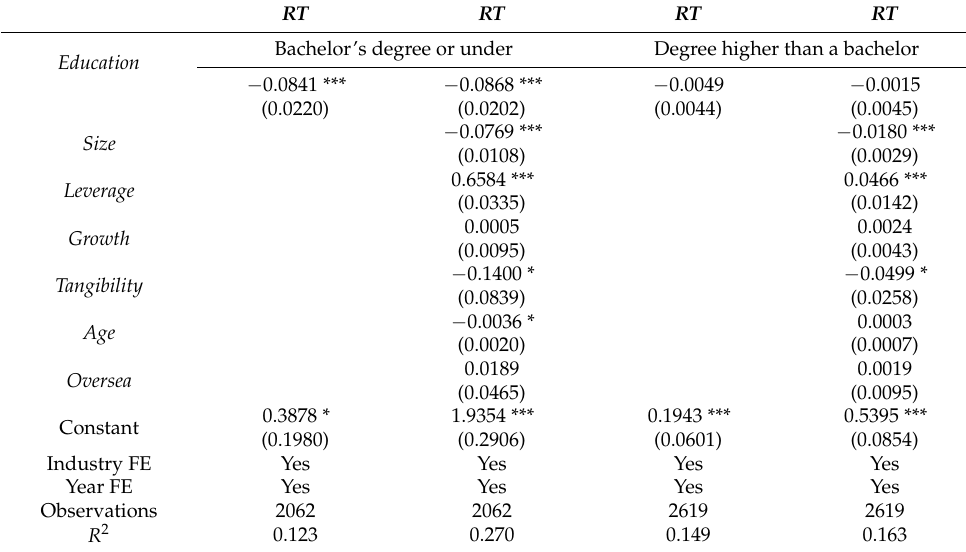
Table 5. Subsample analysis based on education